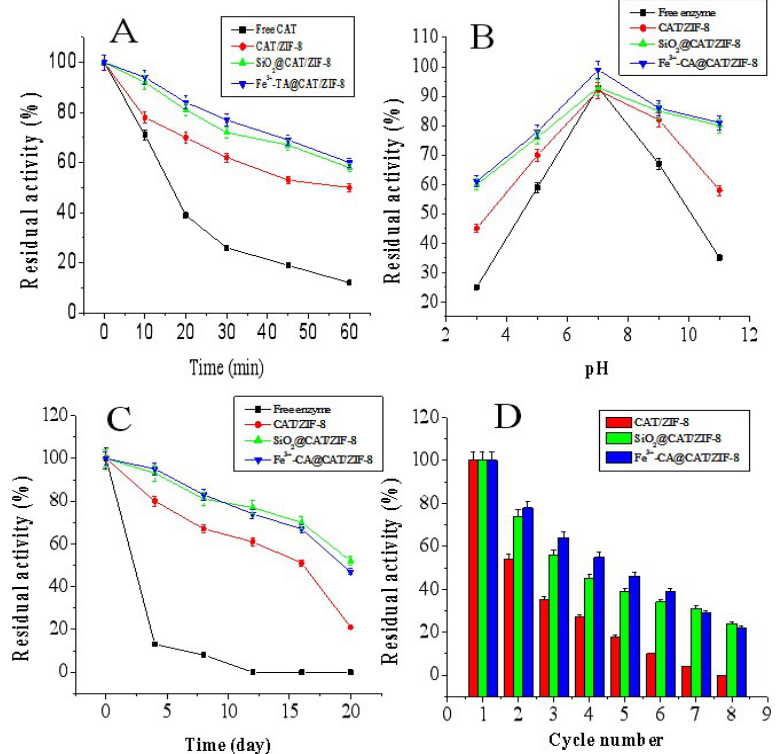
Figure 10. Stability of free CAT, CAT/ZIF-8, Fe 3+ -TA@CAT/ZIF-8, and SiO 2 @CAT@ZIF-8. ( A ) thermostability, ( B ) pH-stability, ( C ) storage stability, ( D ) reusability.